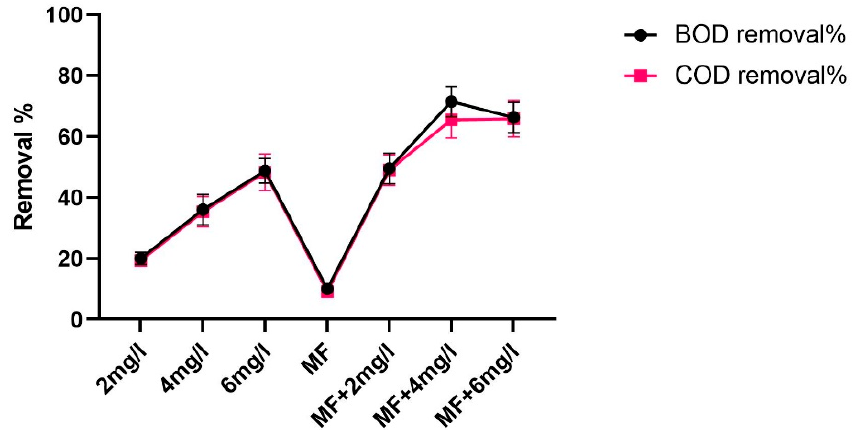
Figure 3. Organics removal % of secondary effluents of SHWW treated by different disinfection methods; (l) 2, 4, and 6 mg/L active chlorine; Disinfection with 12% ( w/v ) commercial NaClO (2) disinfection with magnetic field; and (3) MF+ 2 mg/L, MF+ 4 mg/L, and MF+ 6 mg/L; pretreatment with magnetic field then disinfection with NaClO.